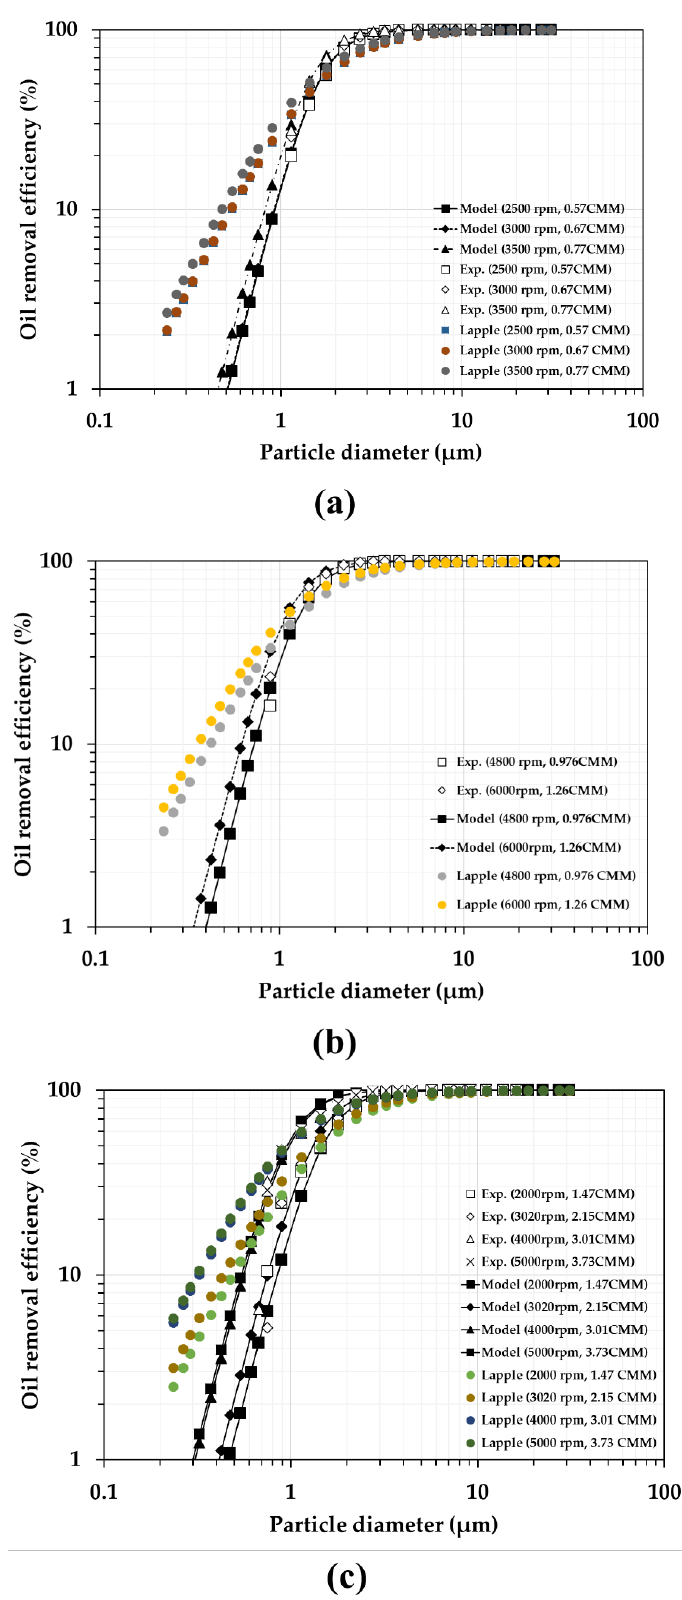
Figure 10. Experimental oil-removal efficiencies and approximate theoretical efficiencies derived using the Lapple and logistic equations: ( a ) cyclone with 120 W motor, ( b ) cyclone with 750 W motor, ( c ) cyclone with 1.5 kW motor.